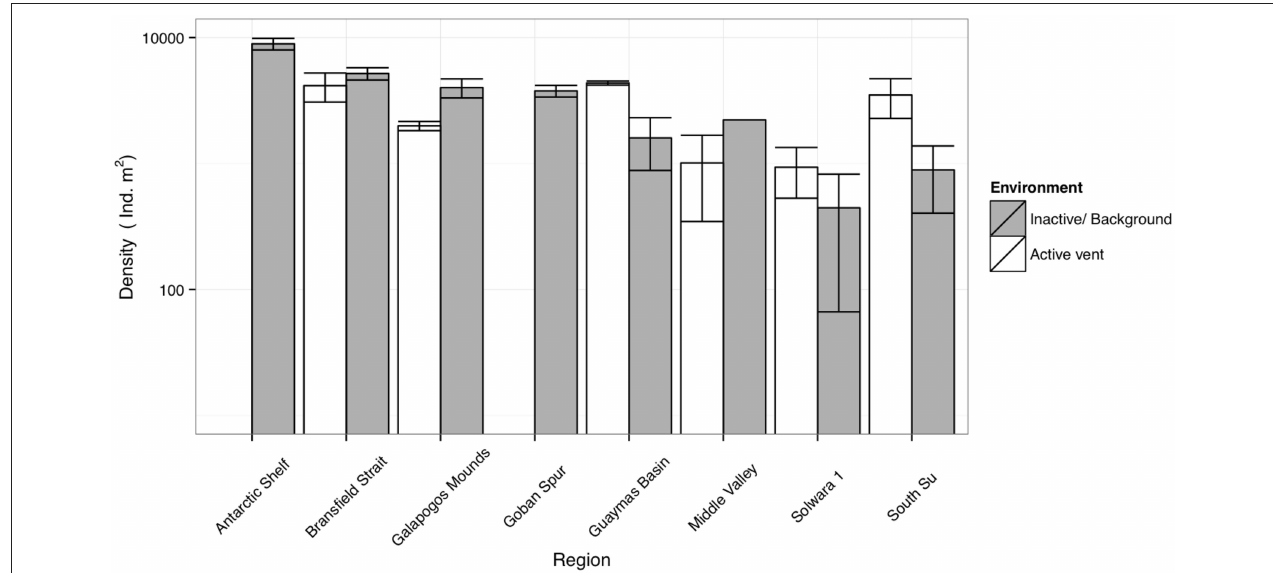
FIGURE 7 | Comparative macrofaunal densities between Bransfield Strait sites (this study) and literature values for other diffuse hydrothermal vents ( Grassle et al., 1985; Levin et al., 2009) and typical bathyal sediments of the West Antarctic Peninsula (polychaetes only; Neal et al., 2011) and Goban spur, NE Atlantic ( Flach and Heip, 1996). Error bars denote ± 1